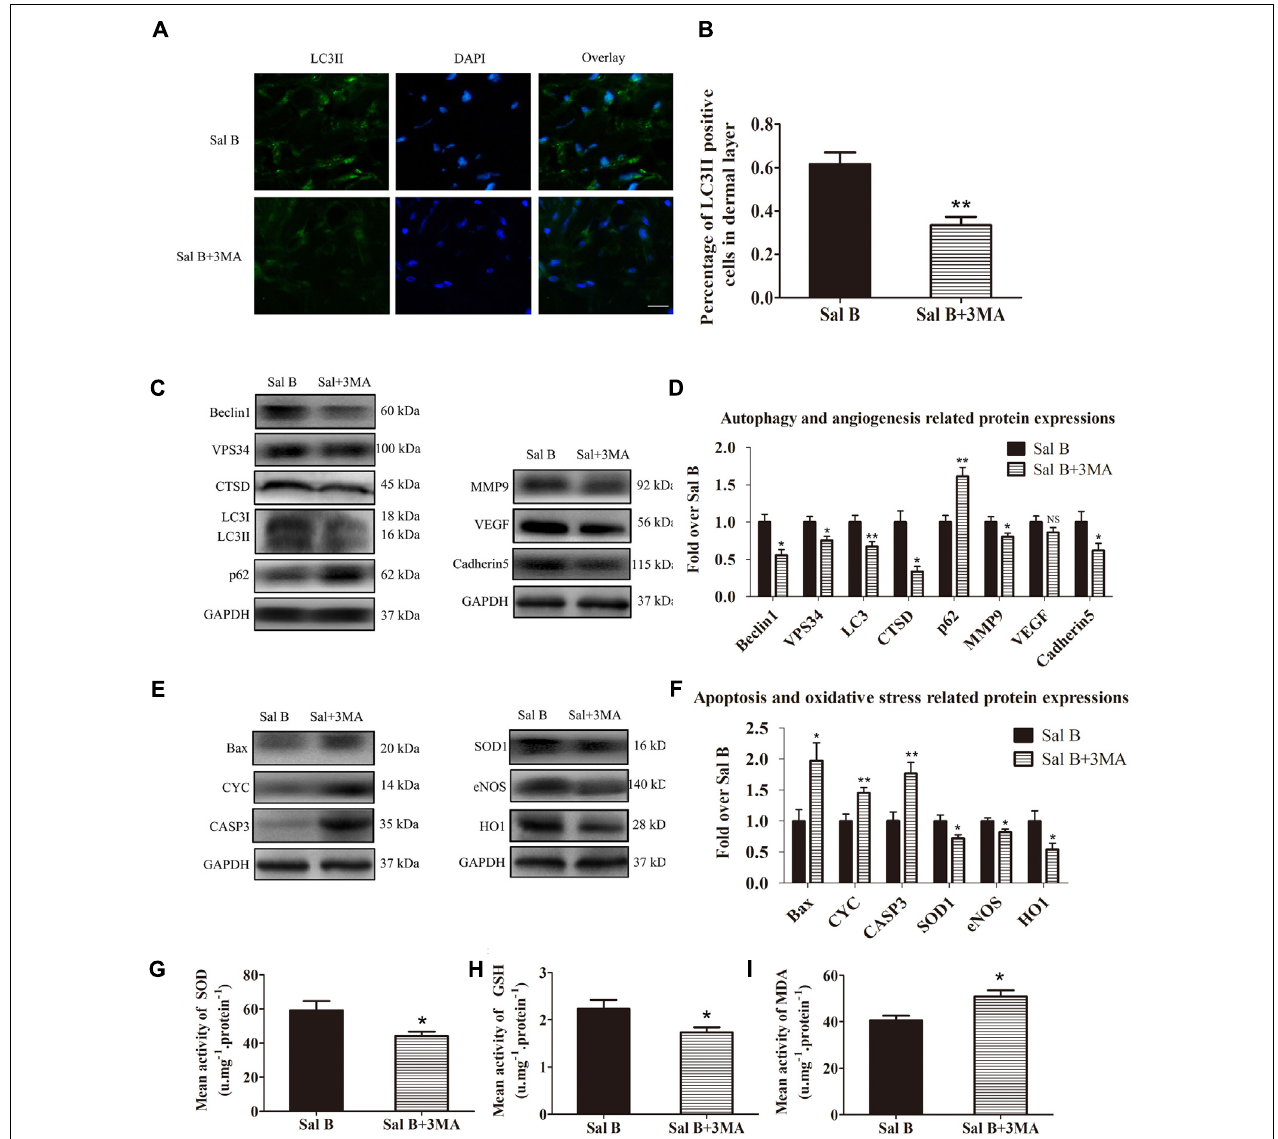
FIGURE 6 | Inhibition of autophagy reverses the effects of Sal B in random skin flaps. Rats were killed and the samples in middle part of flap area II were harvested for analysis on post-operative day 7. (A) Autophagy level in skin flaps were estimated by immunofluorescence staining of LC3II:Autophagosomes (green) in the dermis in area II in each group; nuclei counterstained with DAPI (blue) (scale bar: 15 µ m). (B) Histogram of frequency of LC3II-positive cells in the dermis. (C) Western blotting of Beclin1, VPS34, CTSD, LC3II, and p62 levels, as well as those of MMP9, VEGF, and cadherin 5, corrected by GAPDH as internal control. The gels have been run under the same experimental conditions. The original images are available in Supplementary Figures S2A,B . (D) Histograms of optical density values of autophagy- (Beclin1, VPS34, CTSD, LC3II, and p62) and angiogenesis- (MMP9, VEGF, and cadherin 5) related proteins, assessed by Western blotting. (E) Western blotting of Bax, CYC, and caspase 3 levels, as well as those of SOD1, eNOS, and HO1, corrected by GAPDH as internal control. The original images are available in Supplementary Figures S2C,D . (F) Histograms of optical density values of apoptosis- (Bax, CYC, and caspase 3) and oxidative stress-related proteins (Bax, CYC, and caspase 3) as determined by Western blotting. (G) Total SOD activity by xanthine oxidase method. (H) GSH level by modified 5,5 (cid:48) -dithiobis [2-nitrobenzoic acid] method. (I) MDA level by modified thiobarbituric acid test. ∗ p < 0.05 and ∗∗ p < 0.01 vs. the control group. Data are means ± SEM ( n = 6 per group); NS, not